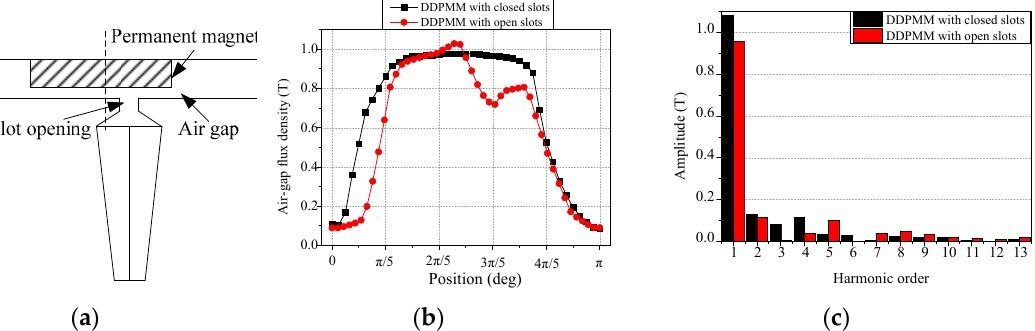
Figure 6. Magnetic field analysis at position 2: ( a ) position 2; ( b ) air-gap flux density waveforms; ( c )